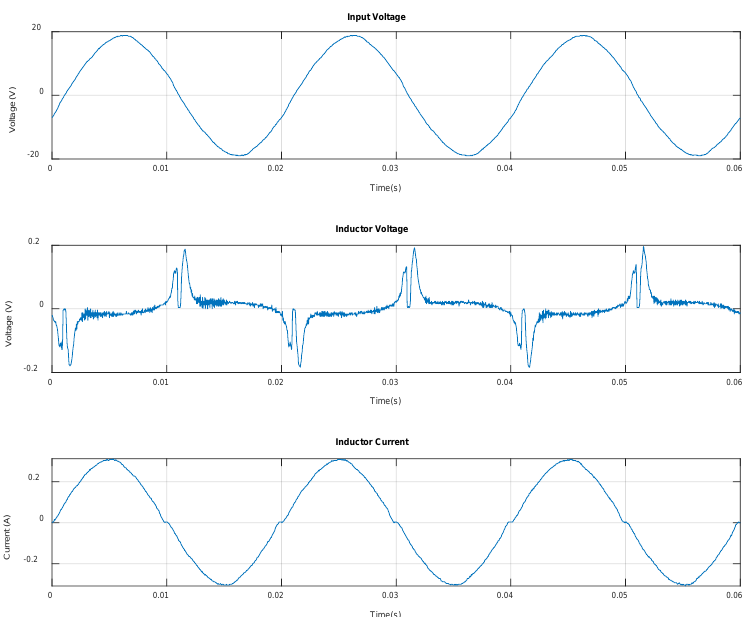
Figure 11. Open loop measurement of real input voltage, inductor voltage, and inductor current.